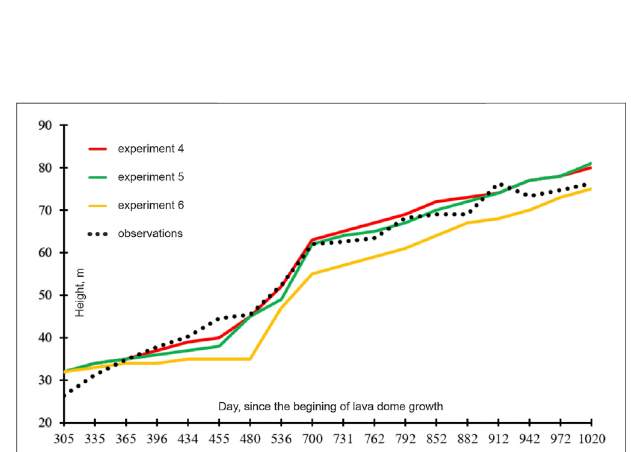
FIGURE 7 | Comparison of the maximum heights of the lava dome at Volcán de Colima (Bretón-González et al., 2013) with those of the modeled